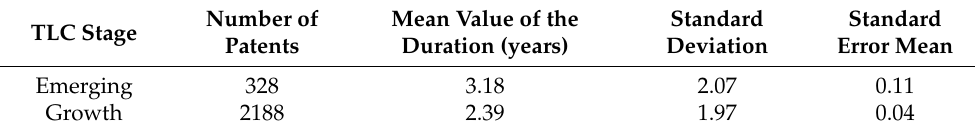
Table 1. Descriptive analysis of patents at different TLC stages.